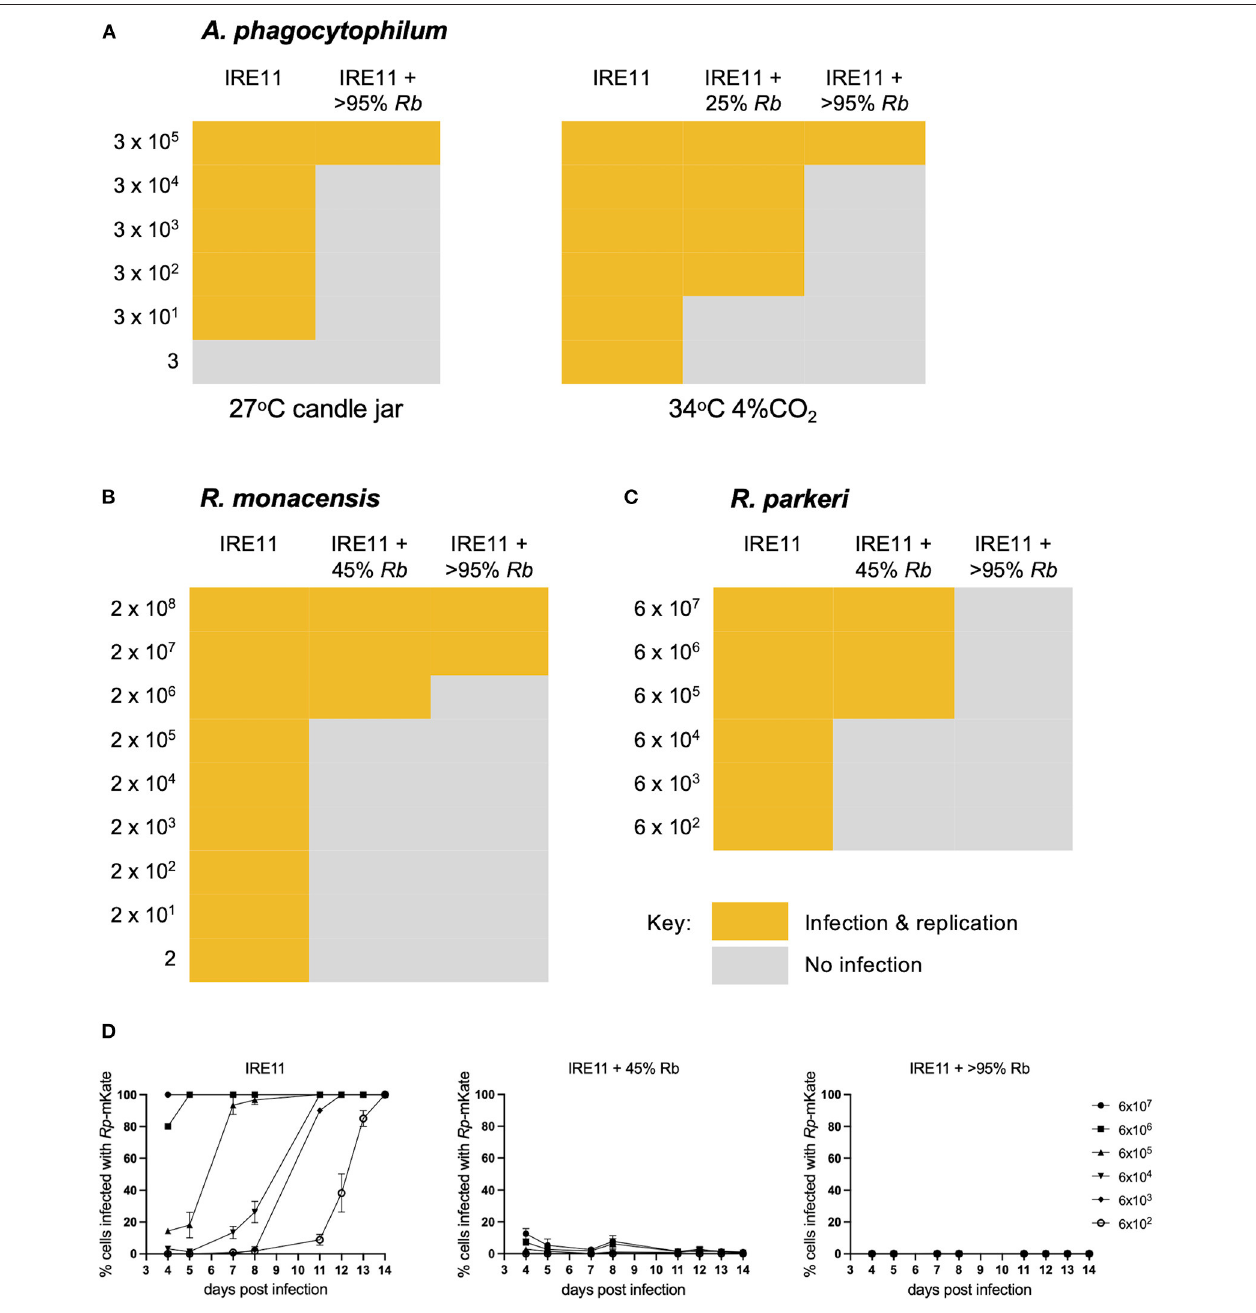
FIGURE 4 | Rickettsia buchneri inhibits infection and replication of other tick-borne bacteria in tick cell culture. IRE11 cells infected with different levels of R. buchneri- GFPuv were infected with serial dilutions of red fluorescent A. phagocytophilum (A) , R. monacensis (B) , or R. parkeri (C) , and plates were monitored over 14 days for infection and replication, compared to uninfected IRE11 cells. (D) The percentage of IRE11 cells infected with R. parkeri- mKate was assessed by fluorescent microscopy. Measurements not taken on days 6, 9, and